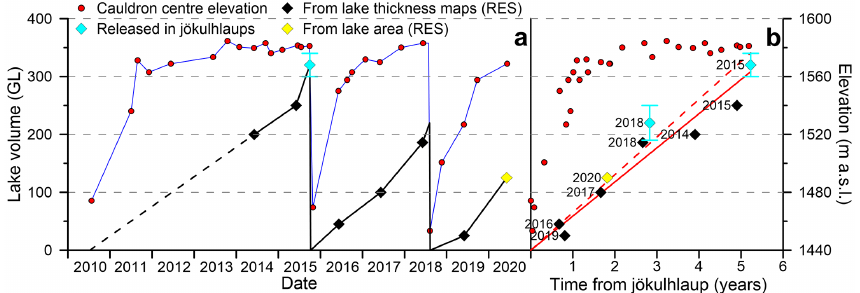
Figure 8. (a) The development of the lake volume (left y axis) in GL (10 6 m 3 ) beneath the ESC in 2010 to 2020 obtained from the RES data (black and yellow diamonds) and derived surface lowering during jökulhlaups adding estimated volume of crevasses (cyan diamonds). The latter includes estimated uncertainty. It is assumed that the lake drained completely during the jökulhlaups in 2010, 2015 and 2018. Red dots show the measured elevation (right y axis) of the ESC centre from radar altimetry and GNSS surface profiling (Gudmundsson and Högnadóttir, 2021). (b) The same lake development and cauldron centre elevation as a function of time elapsed since the previous jökulhlaup. The solid red line shows a linear fit through origin (zero volume at time zero) for the lake development; the dashed red line excludes the RES surveys in